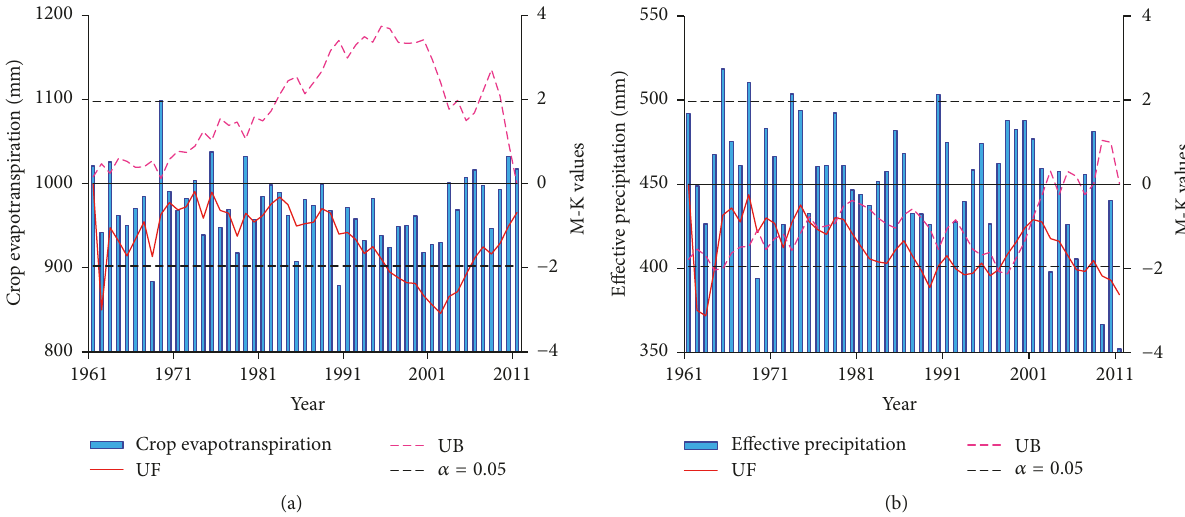
Figure 8: Crop evapotranspiration and effective precipitation during 1961 to 2011 and Mann-Kendall’s testing statistical values: (a) areal crop evapotranspiration; (b) areal effective